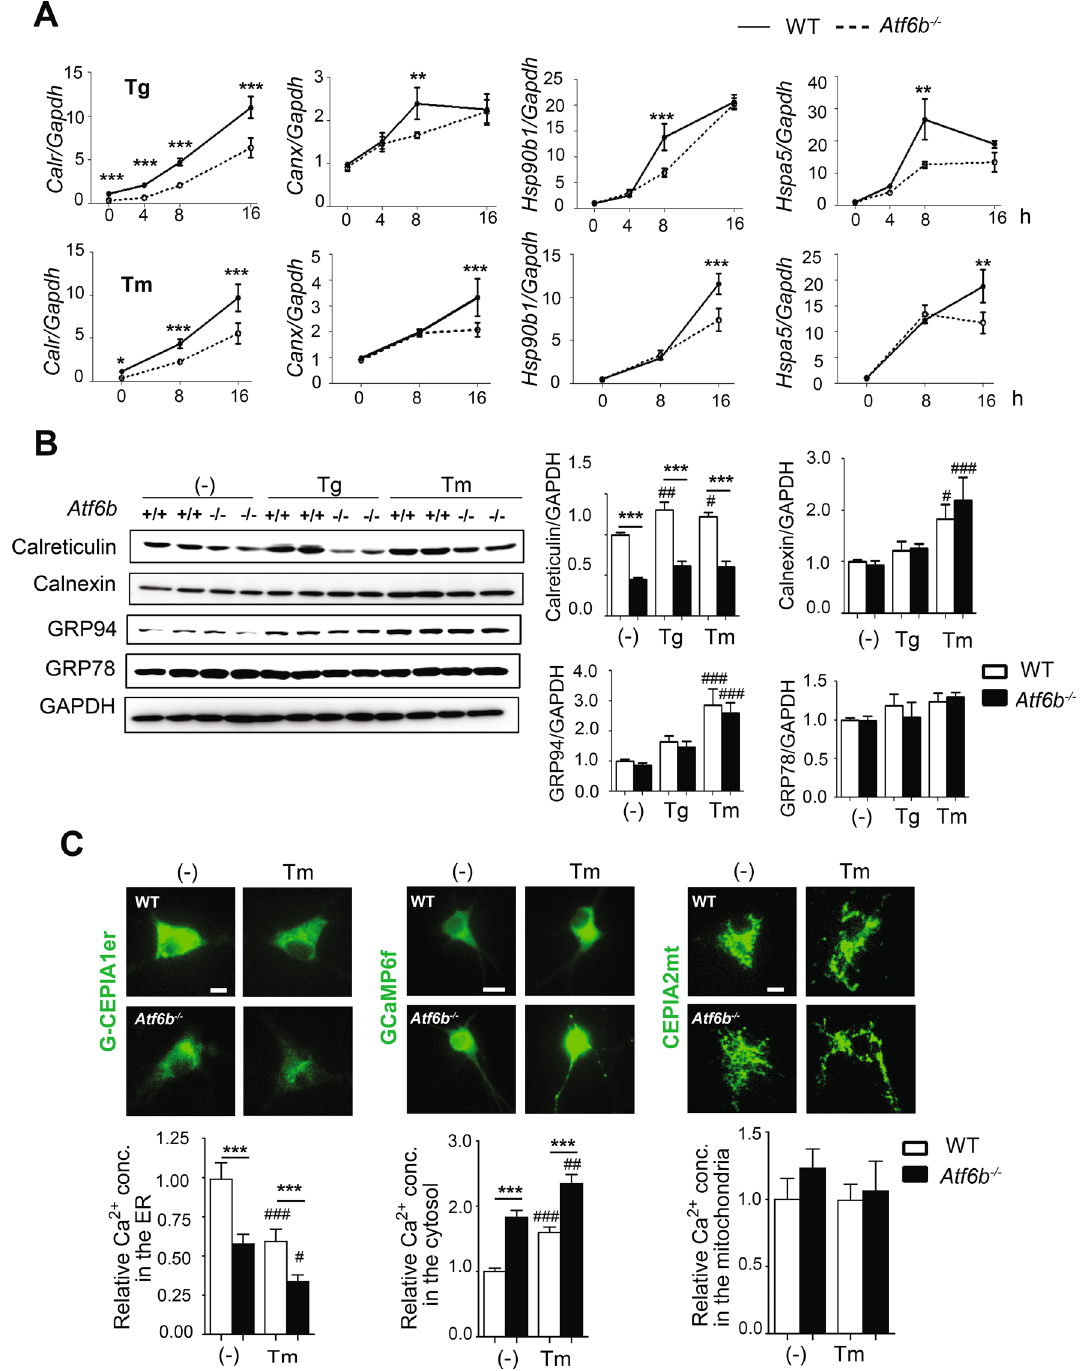
Figure 3. Expression of molecular chaperones in the ER and Ca 2+ levels in WT and Atf6b −/− hippocampal neurons. ( A ) Total RNA was isolated from WT and Atf6b −/− hippocampal neurons (n = 3–8), and qRT-PCR was performed with the indicated primers. Data are shown as mean ± SEM. *p < 0.05, **p < 0.01, ***p < 0.001 between two genotypes by a two-way ANOVA followed by the Bonferroni test. Note that expression of Calr mRNA was significantly lower in Atf6b −/− neurons than in WT neurons under both normal and ER stress conditions. ( B ) Protein samples extracted from WT and Atf6b −/− hippocampal neurons exposed to control or ER stress conditions for 16 h (n = 5–6) were analyzed by western blotting using antibodies against the indicated proteins. Data are shown as mean ± SEM. ***p < 0.001 between two genotypes and # p < 0.05, ## p < 0.01, ### p < 0.001 compared to normal conditions by a two-way ANOVA followed by the Bonferroni test. Note that expression of CRT protein was significantly lower in Atf6b −/− neurons than in WT neurons under both normal and ER stress conditions. ( C ) Ca 2+ levels in the ER, cytosol and mitochondria of hippocampal neurons were measured using G-CEPIA1er, GCaMP6f. and CEPIA2mt, respectively under normal and ER stress (Tm for 3 h) conditions. n = 60–250 cells in each condition from two independent experiments. Data are shown as mean ± SEM. ***p < 0.001 between two genotypes and # p < 0.05, ## p < 0.01, ### p < 0.001 compared to normal conditions by a two-way ANOVA followed by the Bonferroni